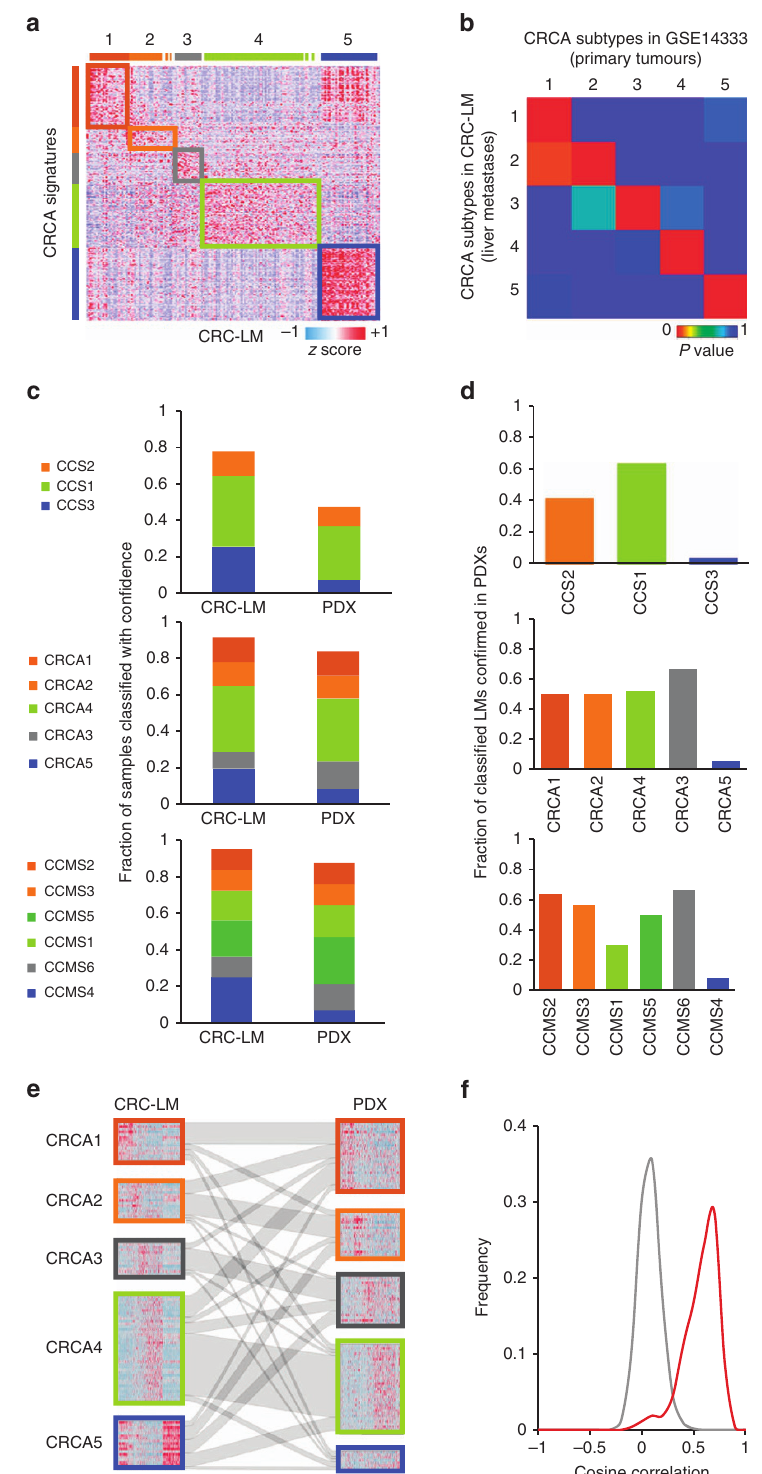
Figure 1 | CRC PDXs fail assignment to public transcriptional subtypes. ( a ) Heatmap showing NTP classification of the CRC-LM data set based on the signatures of the CRCA classification system. ( b ) Submap analysis of CRCA subtype similarity between CRC liver metastases (CRC-LM) and primary tumours (GSE14333). P values are calculated by Fisher’s exact test using the Submap tool available from Gene Pattern. ( c ) Column chart showing the fractions of CRC liver metastases (CRC-LM), or their corresponding PDXs, which were confidently assigned (NTP, FDR o 0.2) to the subtypes of three different public classifiers. ( d ) Fraction of PDXs assigned to the same class of their corresponding liver metastasis according to the three classifiers (as in c ). ( e ) Caleydo view of correspondences between the CRCA class assignments of CRC-LM samples and those of their PDX counterparts. ( f ) Distribution of Pearson’s correlation values obtained by analysing unmatched (grey line) and matched (red line) CRC-LM/PDX